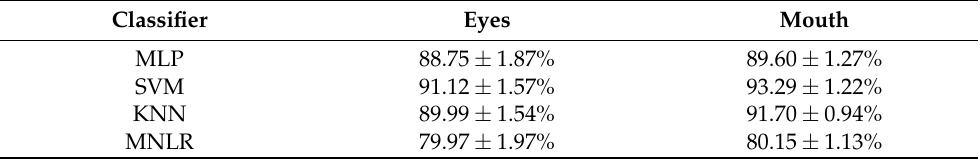
Table 10. Results on the prediction of two palsy levels on the criteria of accuracy using regional